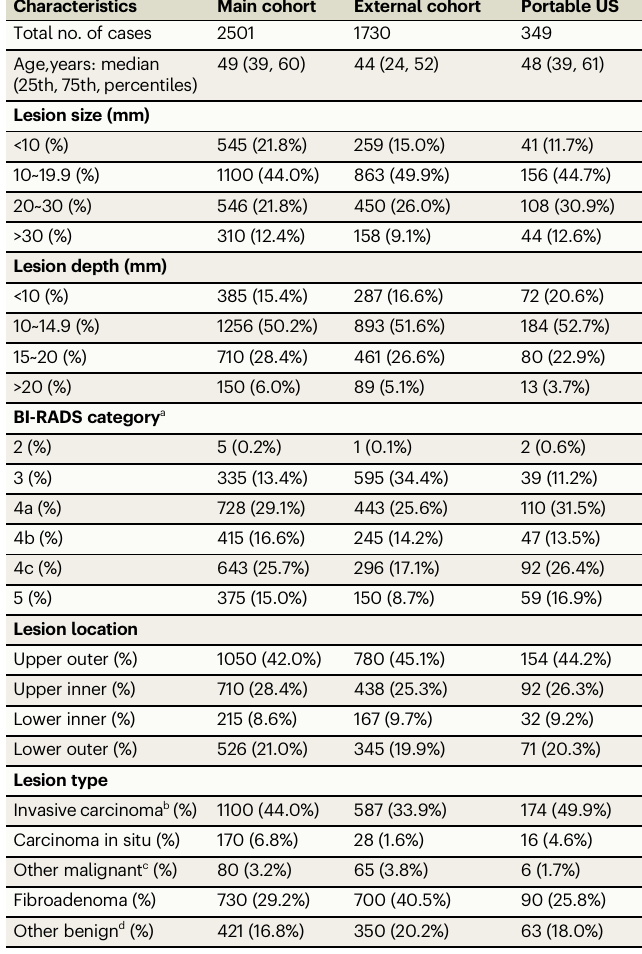
Table 1 | patient demographics and breast lesion characteristics